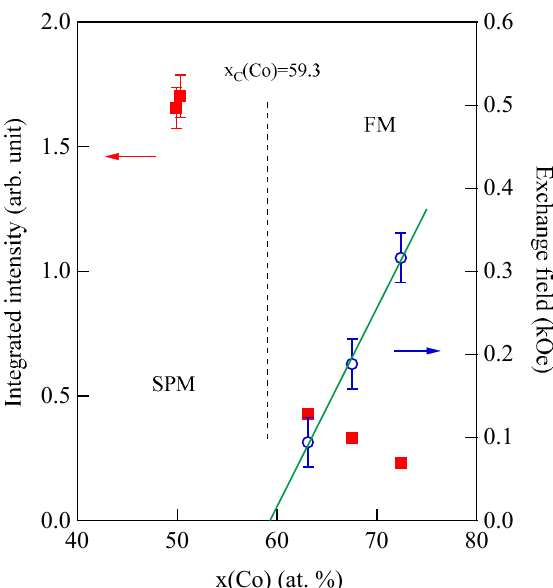
Figure 33. Integrated intensity (solid square) of the Stokes peak of BLS spectra shown in Figure 32 and the exchange field H ex ( ○ ) calculated from the inverse-square law for the FM films as a function of x (Co). The green solid line gives H ex = 23.9 × 10 − 3 ( x (Co) − 59.3) kOe obtained from a least-squares fitting [101]. The broken line indicates the FM/SPM boundary given by H ex =0.